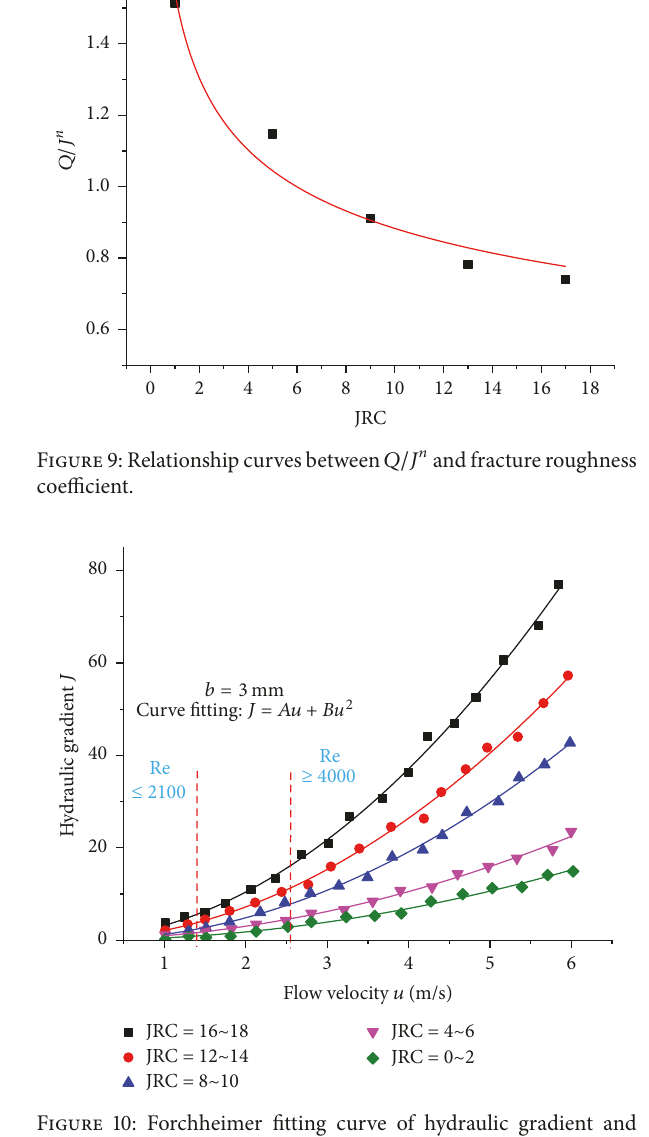
Figure 10: Forchheimer fitting curve of hydraulic gradient and seepage velocity in seepage test of rough